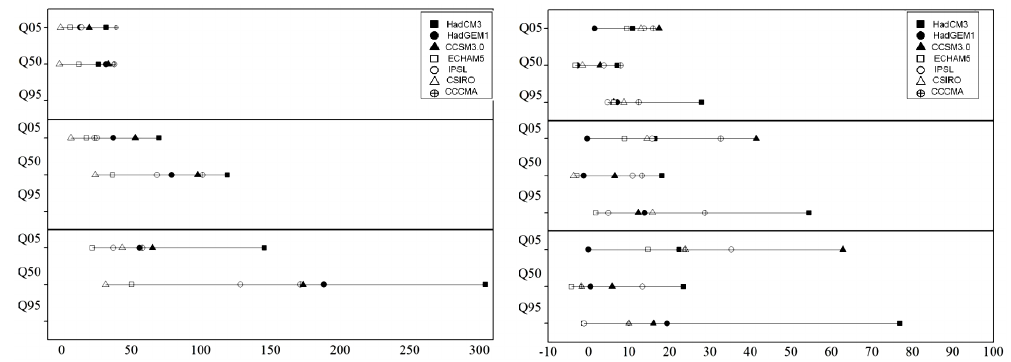
Figure 7. Extreme flow changes for seven GCM projections for the 2020s, 2050s and 2080s time horizons for the rivers Huangfuchuan (left) and Xiangxi (right) (percentage difference from the 1961–1990 baseline) for Q05, Q50 and Q95 (i.e., exceedance in percentage of months over the simulated 30-year period).